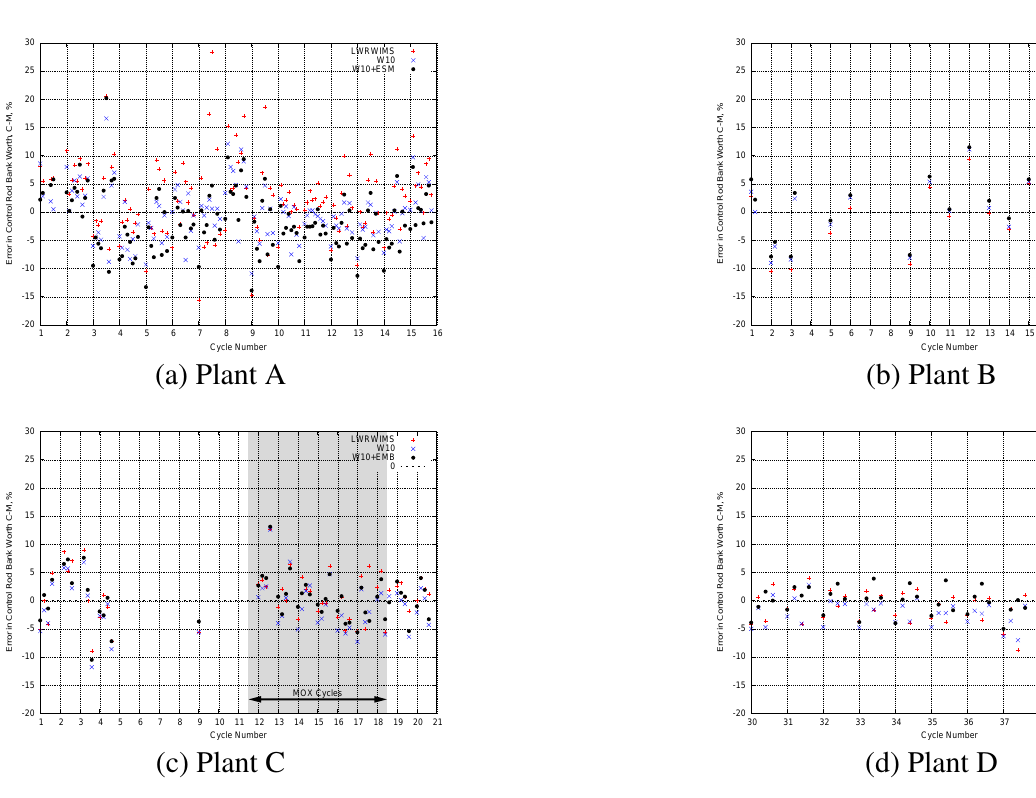
Figure 4: Individual Control Rod Bank Worths at BOC, HZP